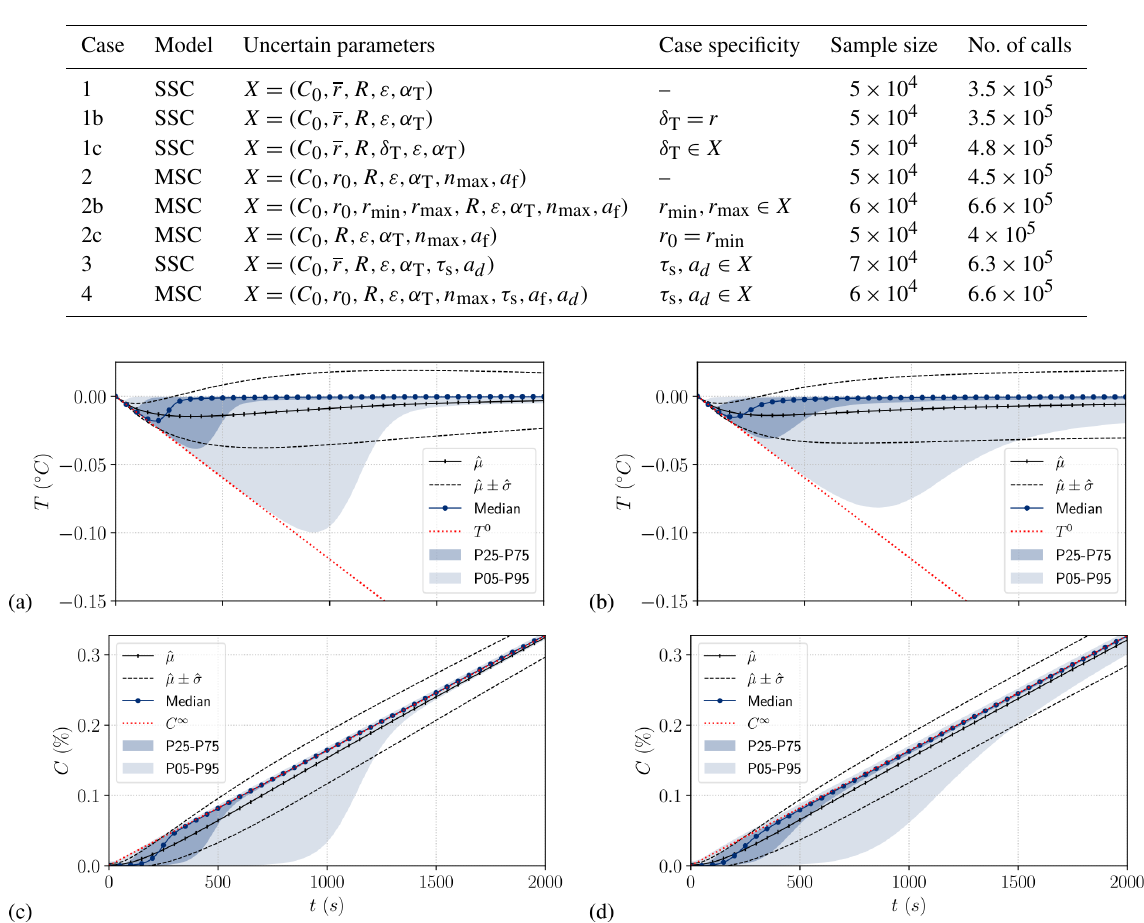
Figure 5. Uncertainty propagation results for SSC (case 1) for temperature (a) and frazil (c) and MSC (case 2) for temperature (b) and frazil (d) : mean, standard deviation, median, and the 5th, 25th, 75th and 95th percentiles are computed for t k (0 ≤ k ≤ n t